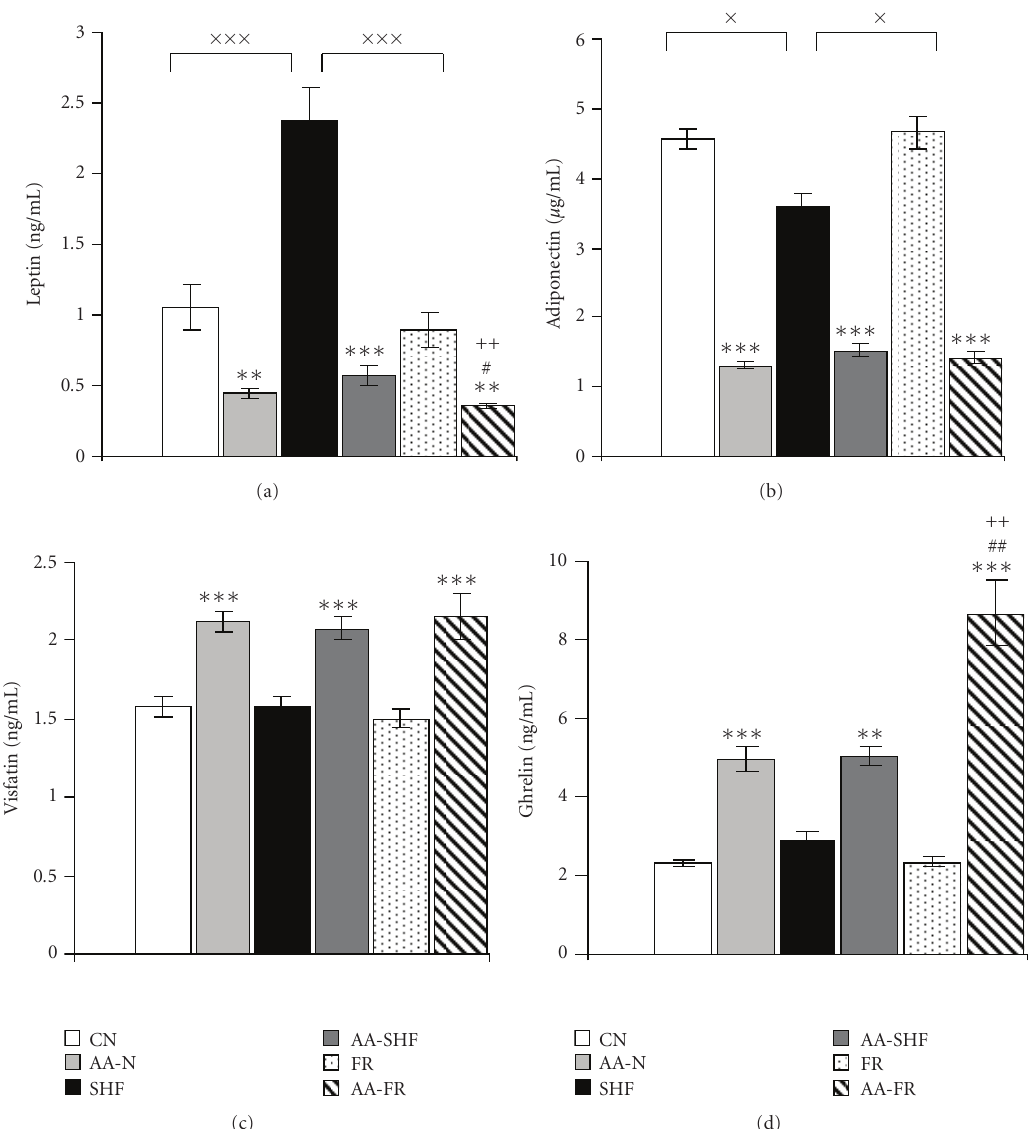
Figure 3: Plasma leptin (a), adiponectin (b), visfatin (c) and (d) ghrelin levels in healthy control (CN, SHF, FR) and arthritic rats (AA-N, AA-SHF, AA-FR) on day 18 after cFA inoculation. Significant di ff erences between healthy controls on di ff erent dietary regime: × P < . 05, ××× P < . 001. Significant di ff erences between control rats and arthritic rats on the same dietary regime: ∗∗ P < . 01, ∗∗∗ P < . 001. Significant di ff erences between dietary modulated arthritic groups: # P < . 05, ## P < . 01 (AA-FR versus AA-N); ++ P < . 01 (AA-FR versus AA-SHF). For abbreviations see Figure